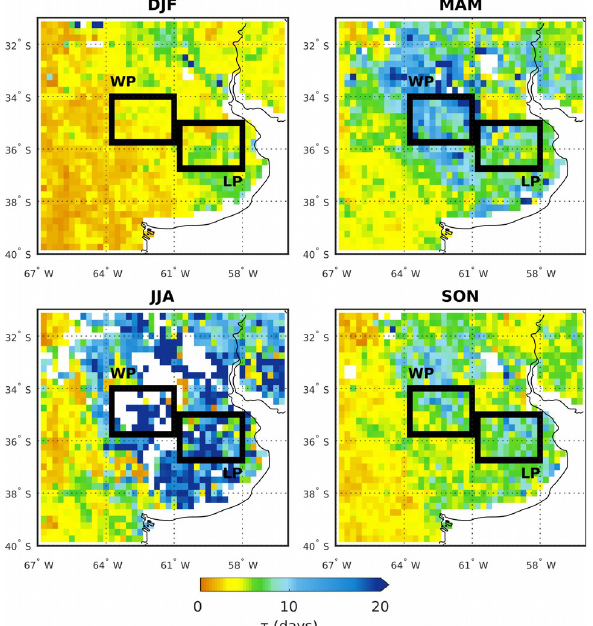
Figure 4. Surface soil drying metric: Maps of seasonal median of τ) (days) computed at each grid point. White colour corresponds to lack of DP or that the SSM values of the DPs identified could not be fitted to the exponential to determine τ).